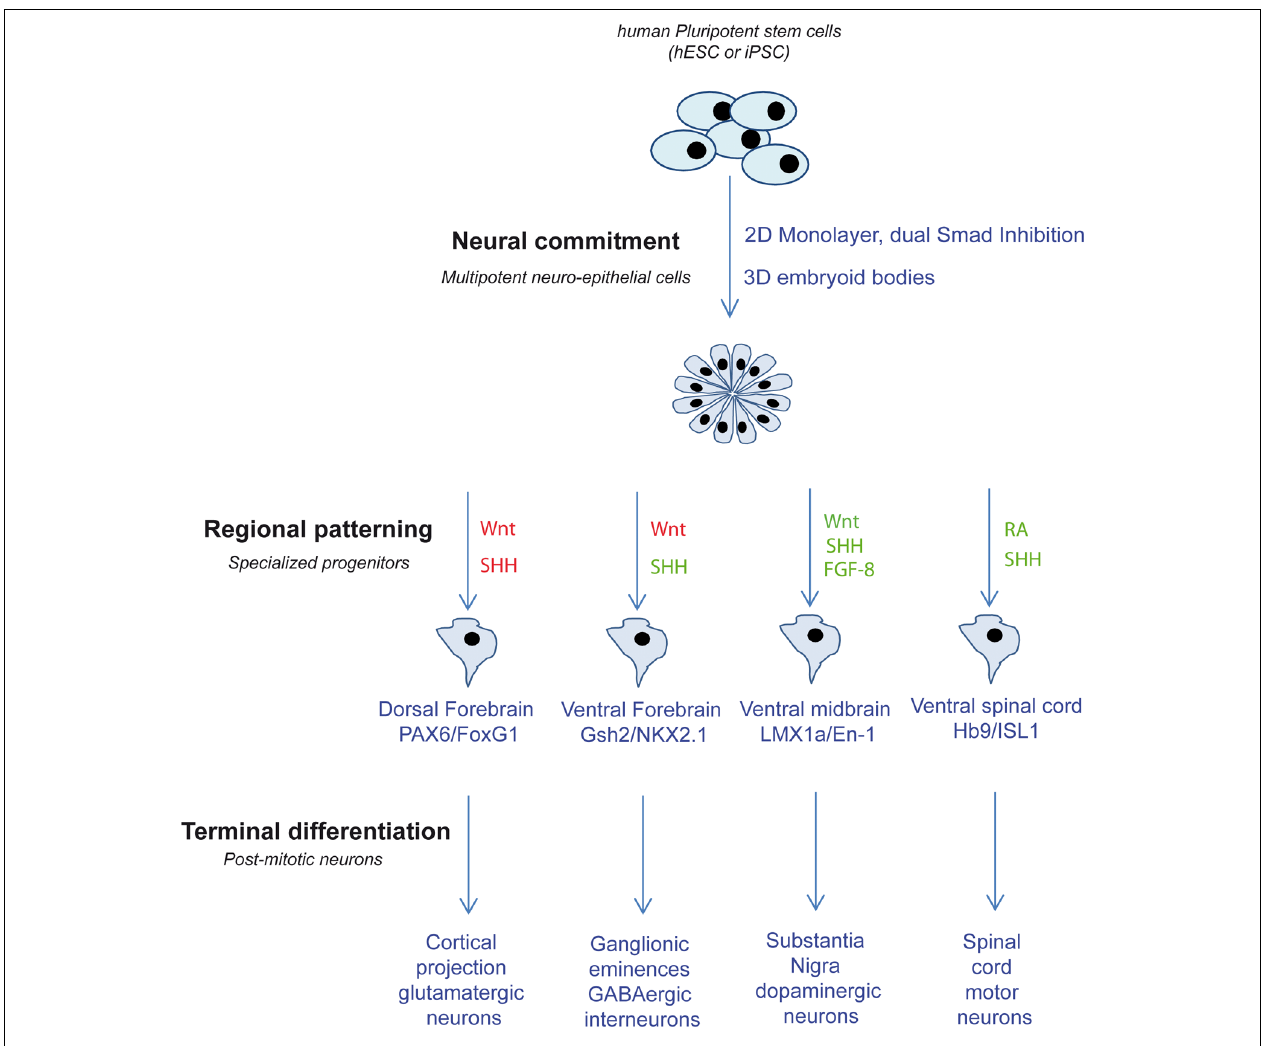
FIGURE 1 | Schematic depicting the different strategies used to produce different neuronal sub-types from PSC. Related pathway activations are in green and inhibitions are in red. SHH, sonic hedgehog; FGF-8, fibroblast growth factors 8; RA, retinoic acid.